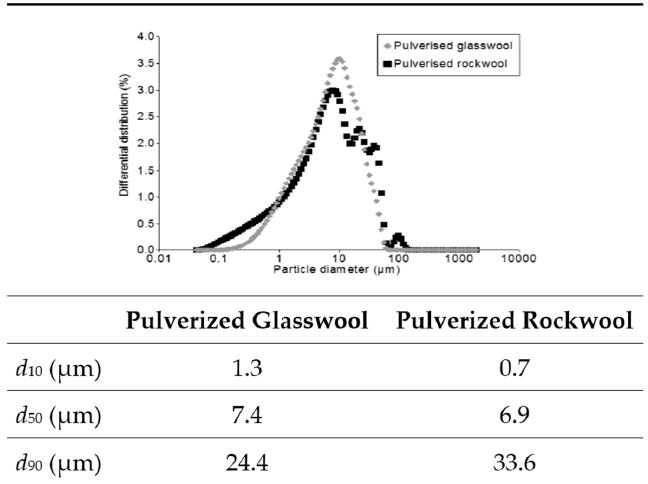
Figure 2. Particle size distributions of pulverized rock wool (RW) and glass wool (GW).